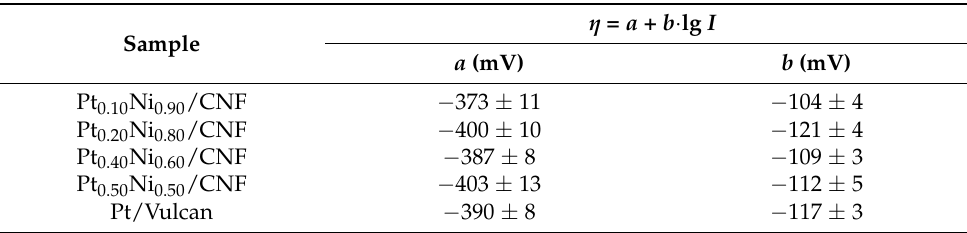
Table 4. The values of the empirical constants of the Tafel equation for the Pt 1 − x Ni x /CNF samples in comparison with the reference sample